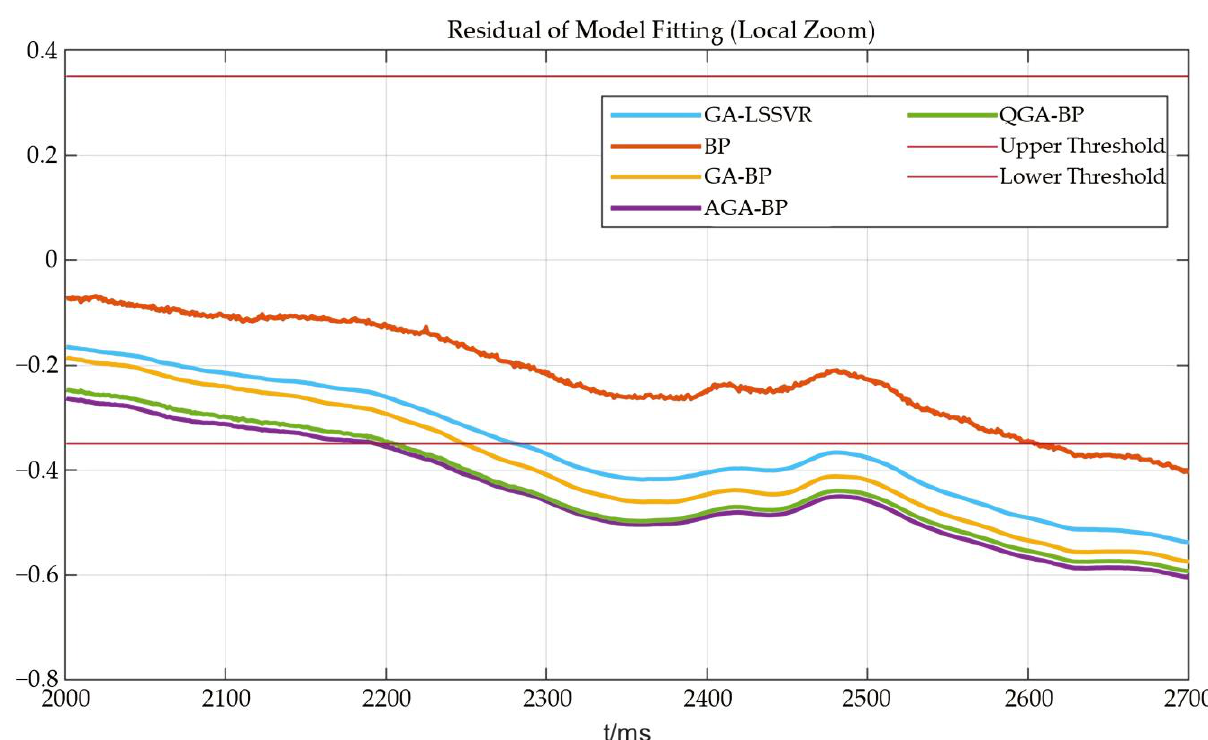
Figure 11. Fault test detection (Figure 9) local amplification (2000 –